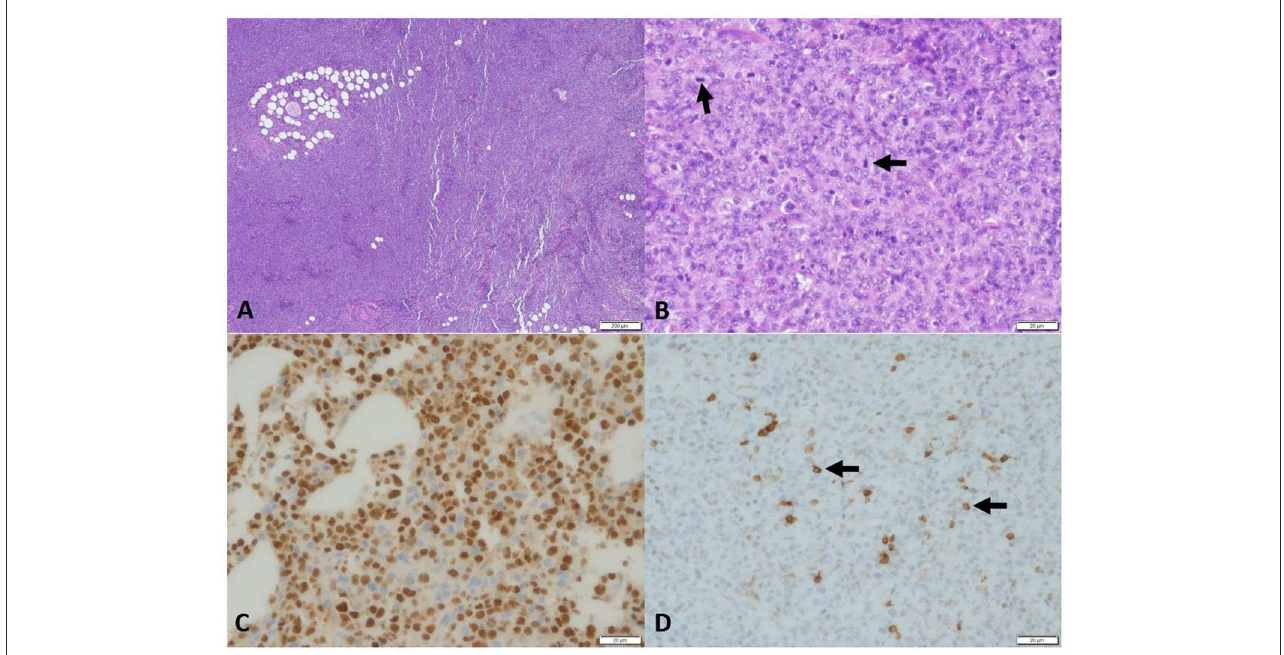
FIGURE3 Photomicrograph of the sample of PBL in the dog. Histopathology of neoplasm, (A) high cellularity, no encapsulation, and infiltration. 4 × , H&E. (B) Round cells, eosinophilic cytoplasm, oval nucleus, and eventually reniform. Chromatin-dispersed single central nucleolus and marked anisokaryosis. Many mitosis figures (arrow), 40 × H&E. Immunohistochemistry, (C) MUM1, Neoplastic cells showed strong nuclear staining. (D) CD79 immunohistochemistry. Some neoplastic cells, 40 × ( < 20%) showed strong cytoplasmic staining, 40 ×